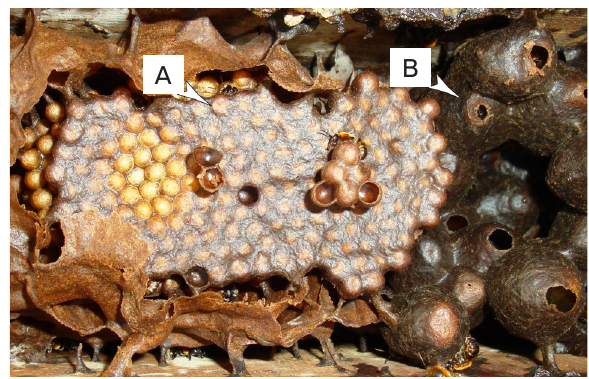
Figura 1. Colmeia de abelhas M. subnitida . (A) Favos de cria; (B) Potes de armazenamento de mel (Fonte: José Maria Vieira